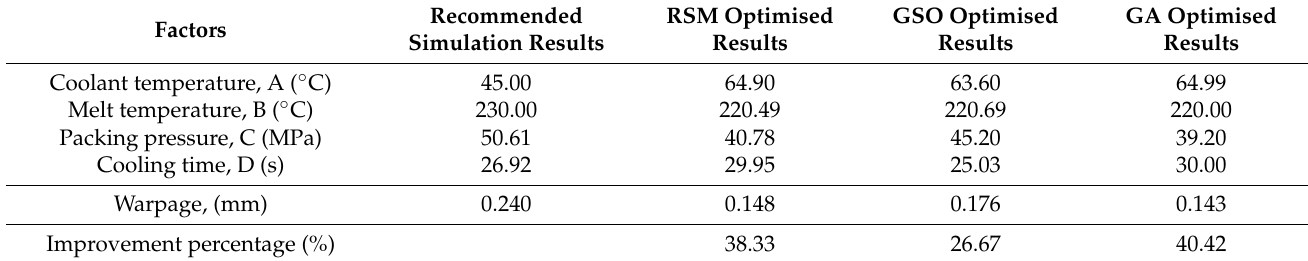
Table 6. Recommended simulation results versus optimised results using Response Surface Methodology (RSM), GSO and GA for straight drilled cooling channels.